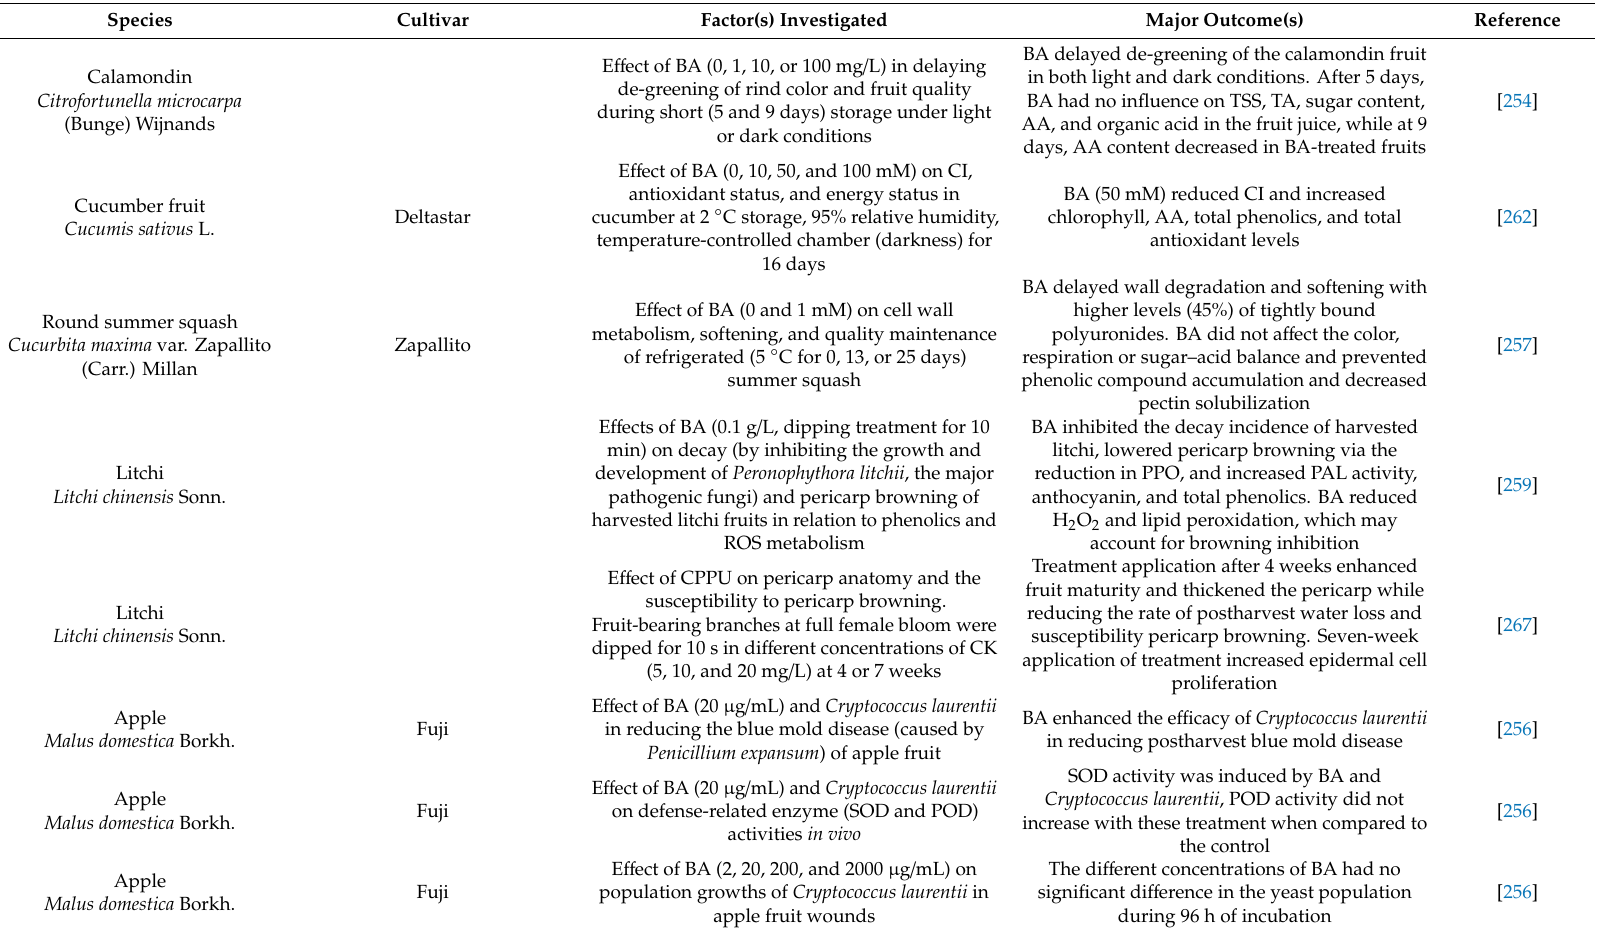
Table 9. E ff ects of postharvest application of cytokinins on postharvest quality of horticultural fruits. Species Major Outcome(s)